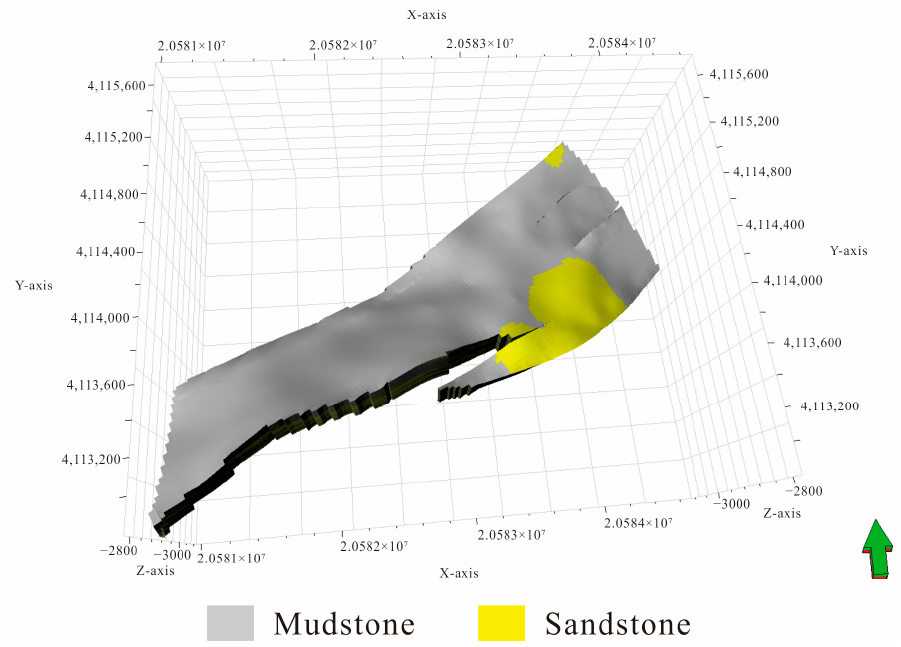
Figure 13. Sandstone-mudstone model of undifferentiated beach and bar sand in Gao89-1 block.